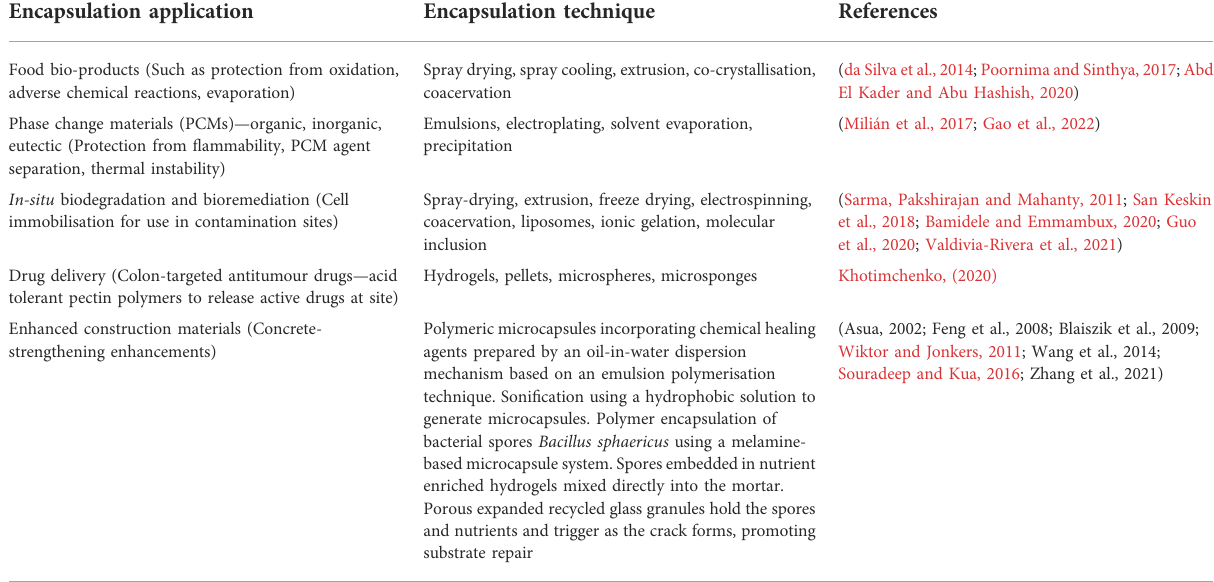
TABLE 3 Applications utilising bacterial inclusion and encapsulation techniques